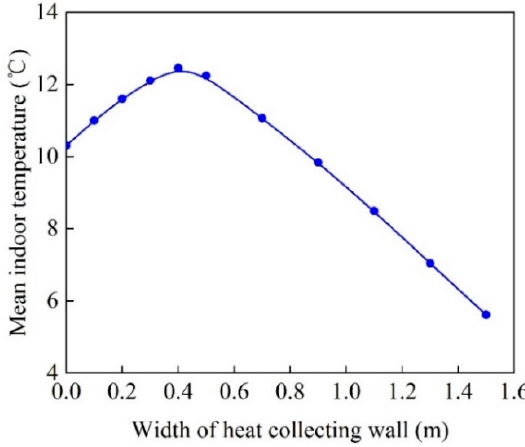
Figure 14. Mean indoor air temperature under different widths of heat collecting wall.